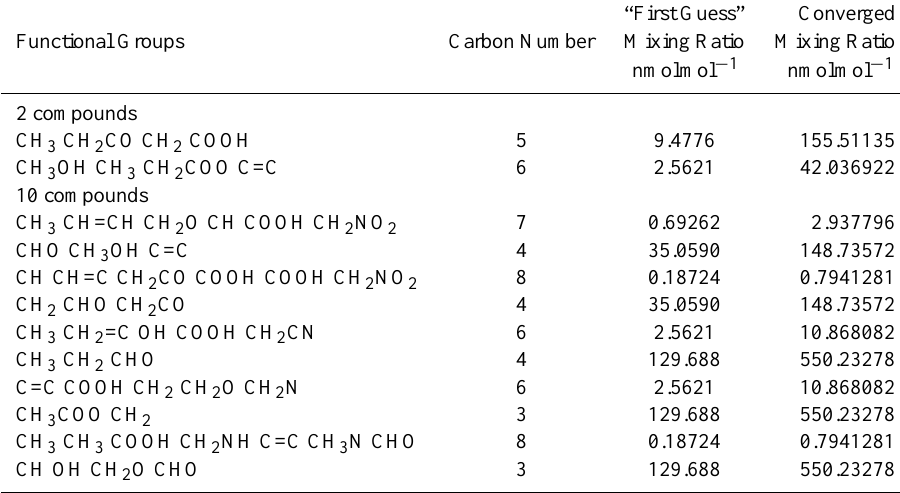
Table 2. Example initialisations satisfying the same random probability of functionality and carbon number. These mixing ratios are illustrated in Fig. 2 in addition to those for each component in the 100, 1000 and 10000 compound representations of the same